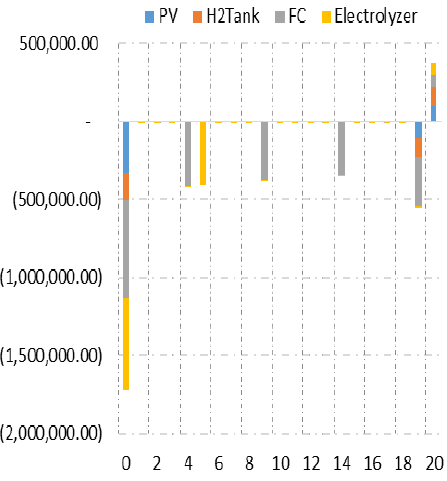
Fig. 6: The discounted cash flow of the optimized system